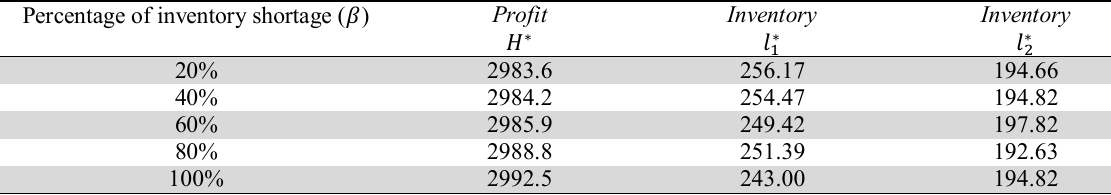
Sensitivity analysis of the ratio ( (cid:2010) ) Percentage of inventory shortage ( (cid:2010)